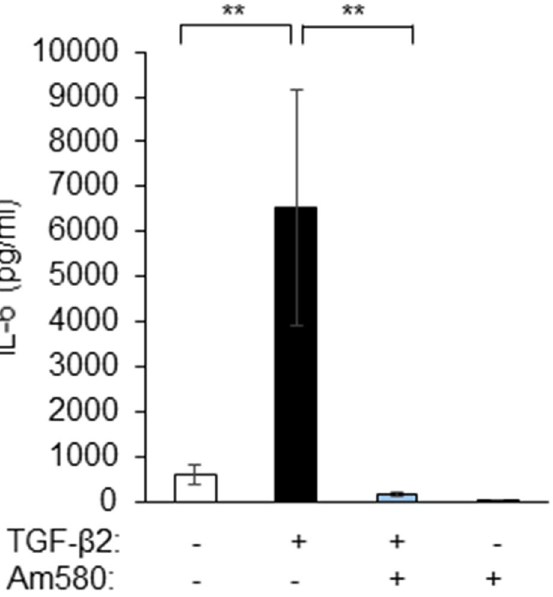
Figure 5. Inhibitory effect of an RAR-α agonist on the TGF-β2-induced release of IL-6 by RPE cells. RPE cells were cultured in collagen gels with or without TGF-β2 (1 ng/ml) and Am580 (10 μM) for 48 h, after which the culture supernatants were assayed for IL-6. Data are means ± s.d. from four independent experiments. ** P < 0.01 (Dunnett’s